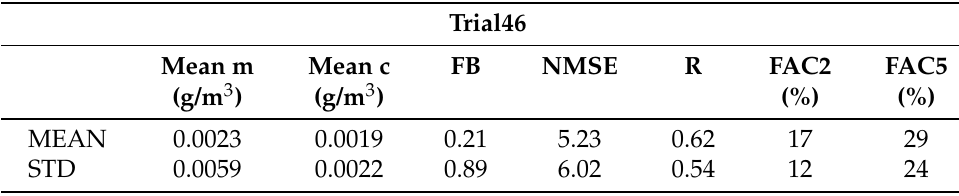
Table 7. Statistical analysis for the mean concentration and the concentration standard deviation in the neutral case trial 46. m indicates measured and c